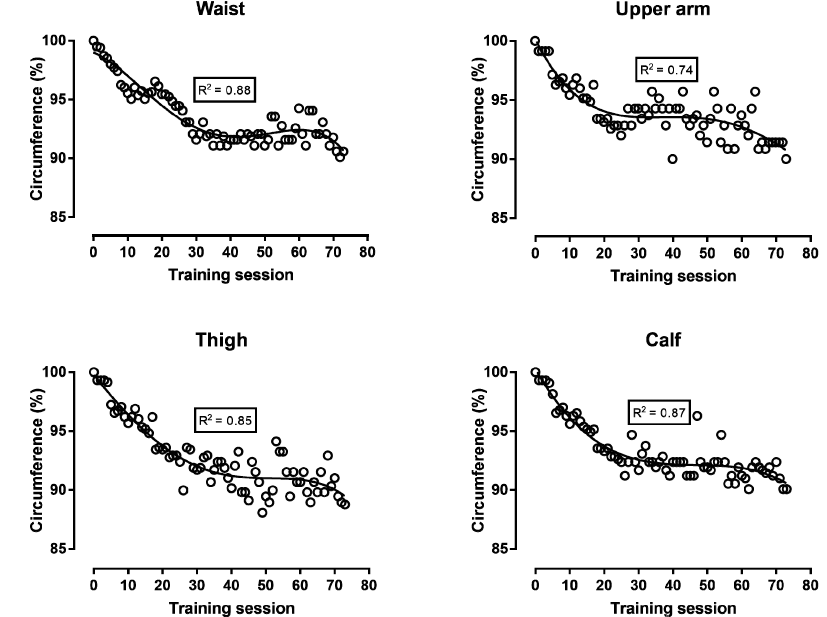
Figure 4. Waist, upper arm, thigh, and calf circumference expressed as a percentage of their baseline values during the preparation for a 48-hour ultra-marathon run.